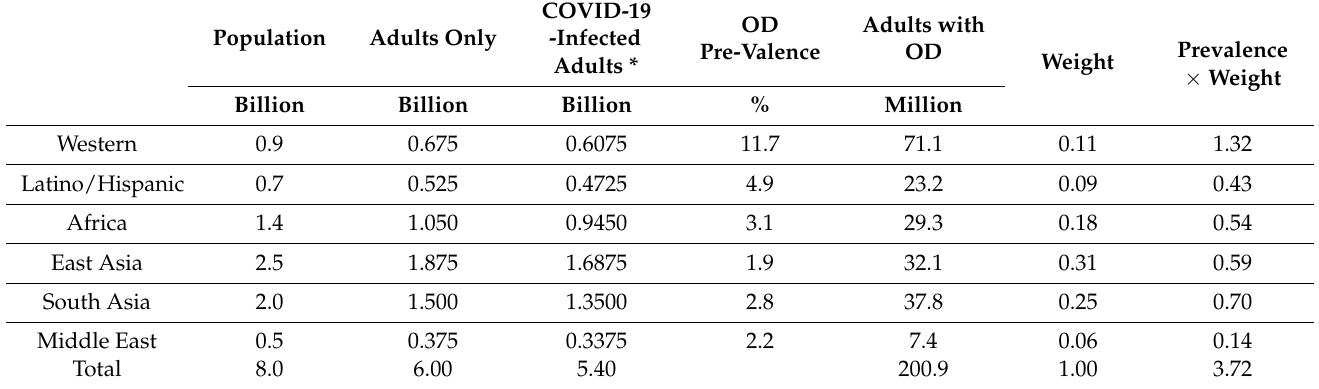
Table 3. Estimation of the number of adults of different ethnicities expected to experience olfactory dysfunction (OD) following infection with the omicron